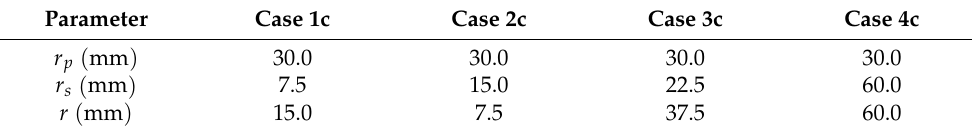
Table 1. Primary test